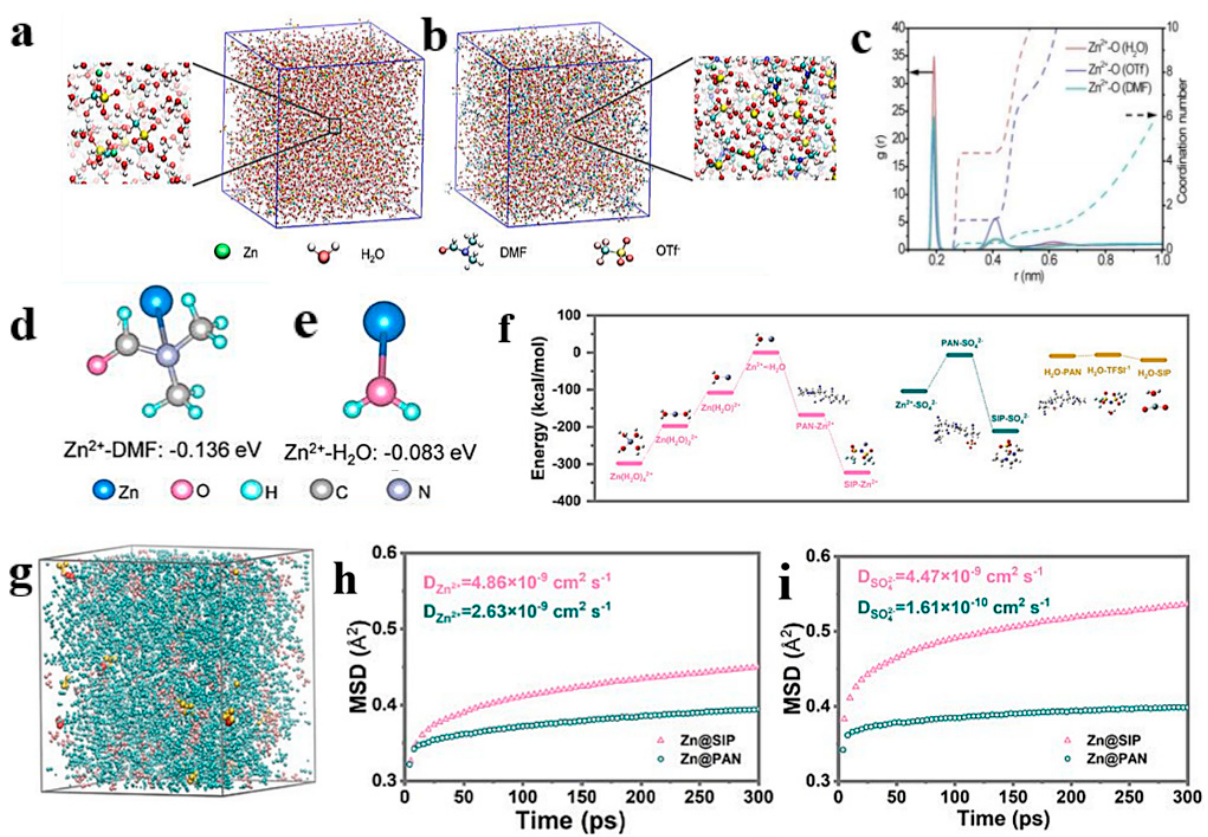
Figure 9. Snapshot of the MD simulation ba tt eries for ( a ) ZOTF and ( b ) ZOTF-2H1D electrolytes. ( c ) RDFs of Zn 2+ -O (H 2 O), Zn 2+ -O (OTf − ), and Zn 2+ -O (DMF) pairs, and the coordination number in the ZOTF-2H1D electrolyte. The calculated adsorption energy of Zn 2+ with ( d ) DMF molecule and ( e ) H 2 O molecule. Reproduced with permission [110]. Copyright 2022 Wiley-VCH. Desolvation process